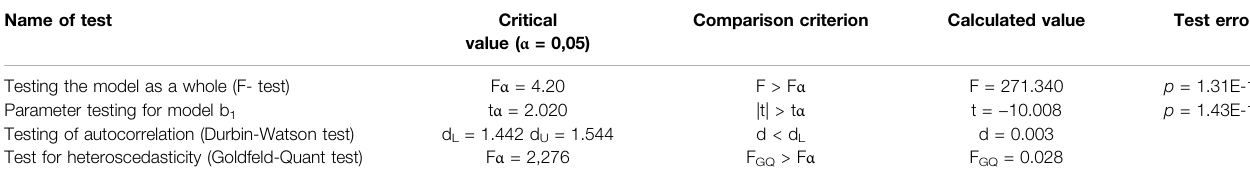
TABLE 4 | Results of the model